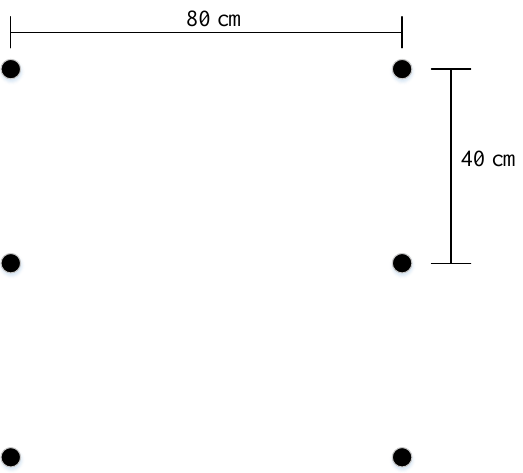
Figure 13. Geometry model schematic diagram with eight straight slotting bores.